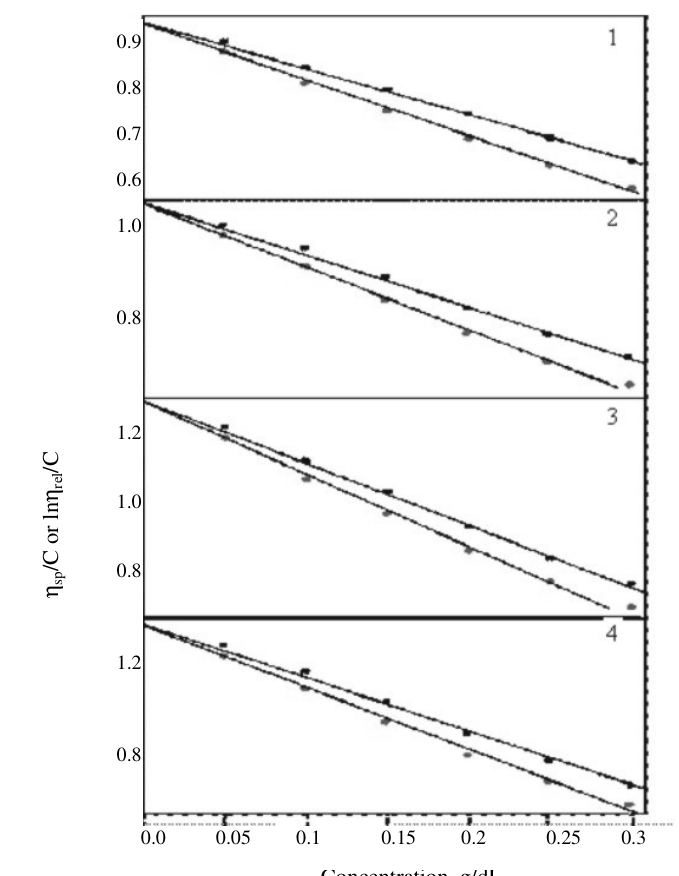
Figure. 1 . Viscometric plots of terpolymers (1) 2, 4-DHBOF-I, (2) 2, 4-DHBOF-II, (3) 2, 4- DHBOF-III, (4) 2, 4-DHBOF-IV According to above relations, a plot of η /C and η /C against C were linear with sp. rel slopes of k and k respectively. Intercepts on the viscosity function axis gave [ η ] valid in 1 2 both plots The calculated values of the constants k and k for the intrinsic viscosities (Table 1 2 2) satisfy the relation k + k = 0.5 favourably 10 . It was observed that terpolymers having 1 2 higher Mn show a higher value of [ η ]. Table 2 . Elemental analysis data of 2, 4-DHBOF terpolymers resins. Elemental analysis, % Intrinsic Terpolymers ]C H N Viscosity [ η Calc. Found Calc. Found